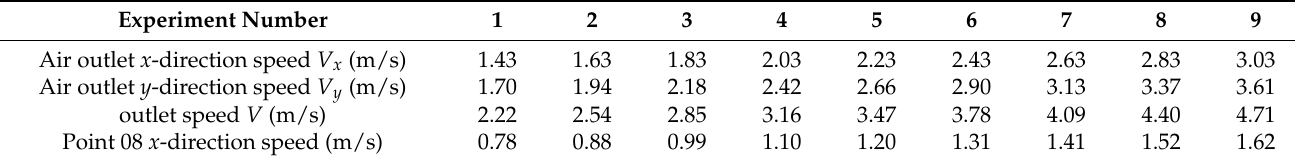
Table 2. Speed in x -direction at point P08 at different flow rates.